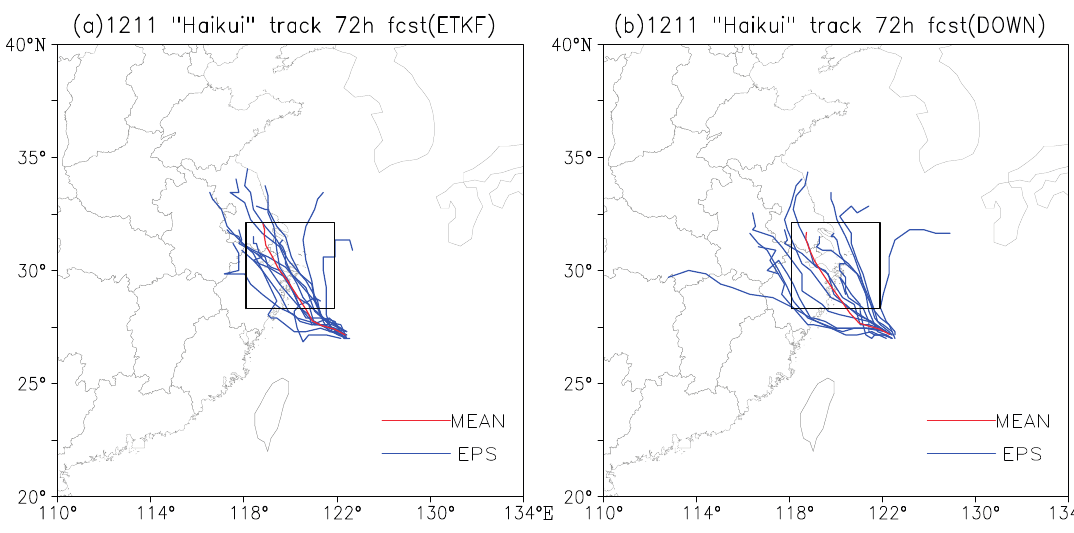
Figure 10. Seventy-two hour track forecasts of Haikui (1211) from ensemble forecasts of ( a ) ETKF and ( b ) DOWN. Red line is ensemble mean forecast (MEAN) and blue lines are ensemble member forecasts